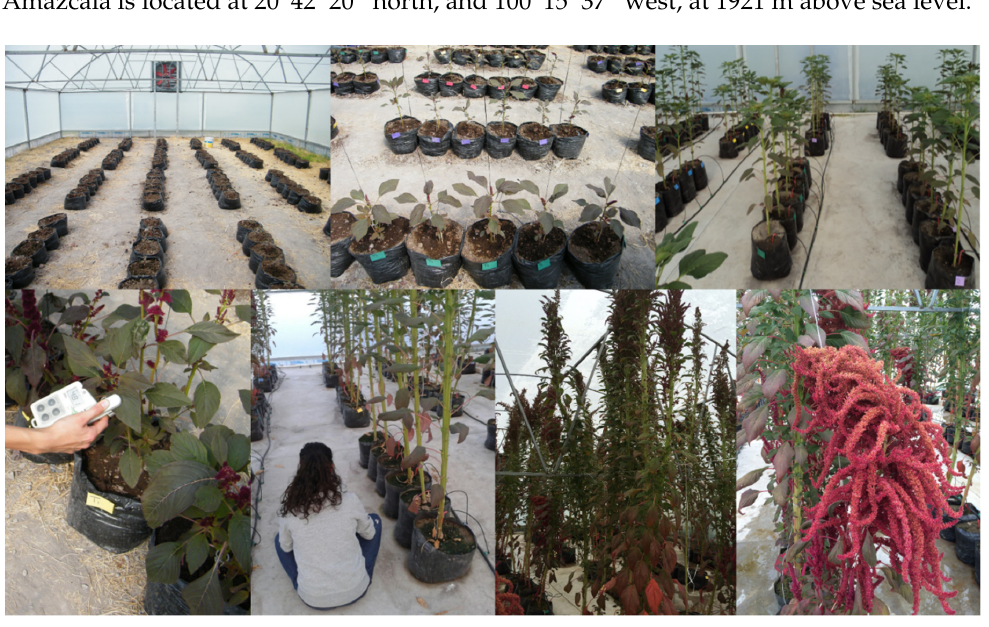
Figure 1. Amaranth ( Amaranthus hypochondriacus L.) growth in the greenhouse during the experi- ment.